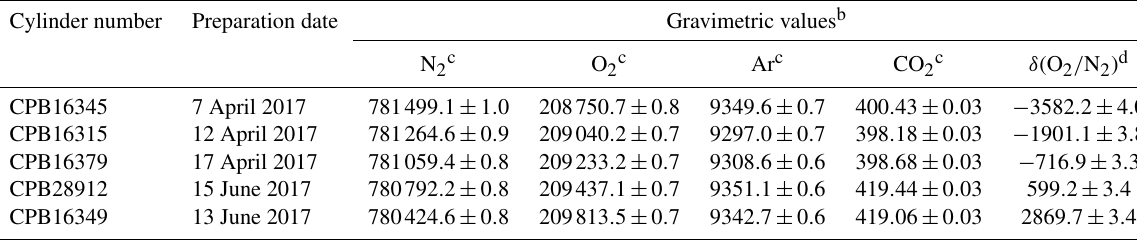
Table 1. The gravimetric values of N 2 , O 2 , Ar, and CO 2 molar fractions and δ (O 2 / N 2 ) in five round-robin standard mixtures prepared by the NMIJ/AIST a .